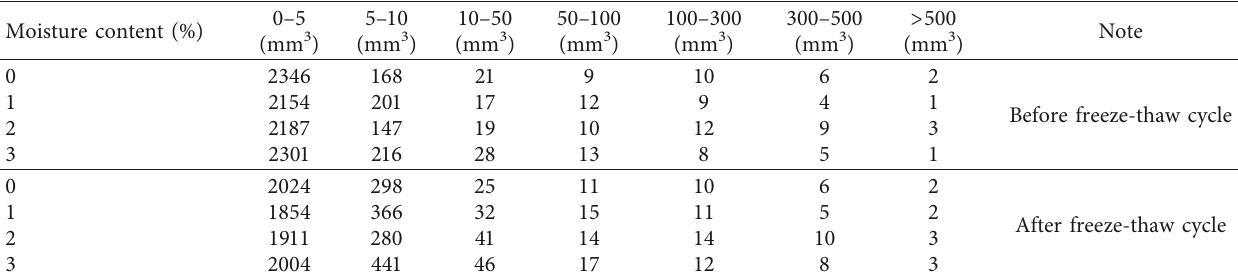
Figure 3: 2D and 3D air void segmentation images of the RH-WMA. Table 10: Air void contents and distributions of the RH-WMA samples through freeze-thaw